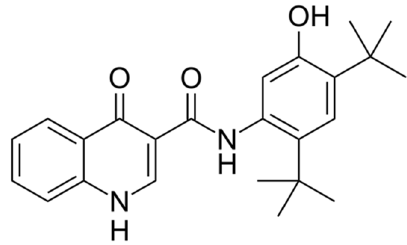
Figure 3. Chemical structure of Ivacaftor.